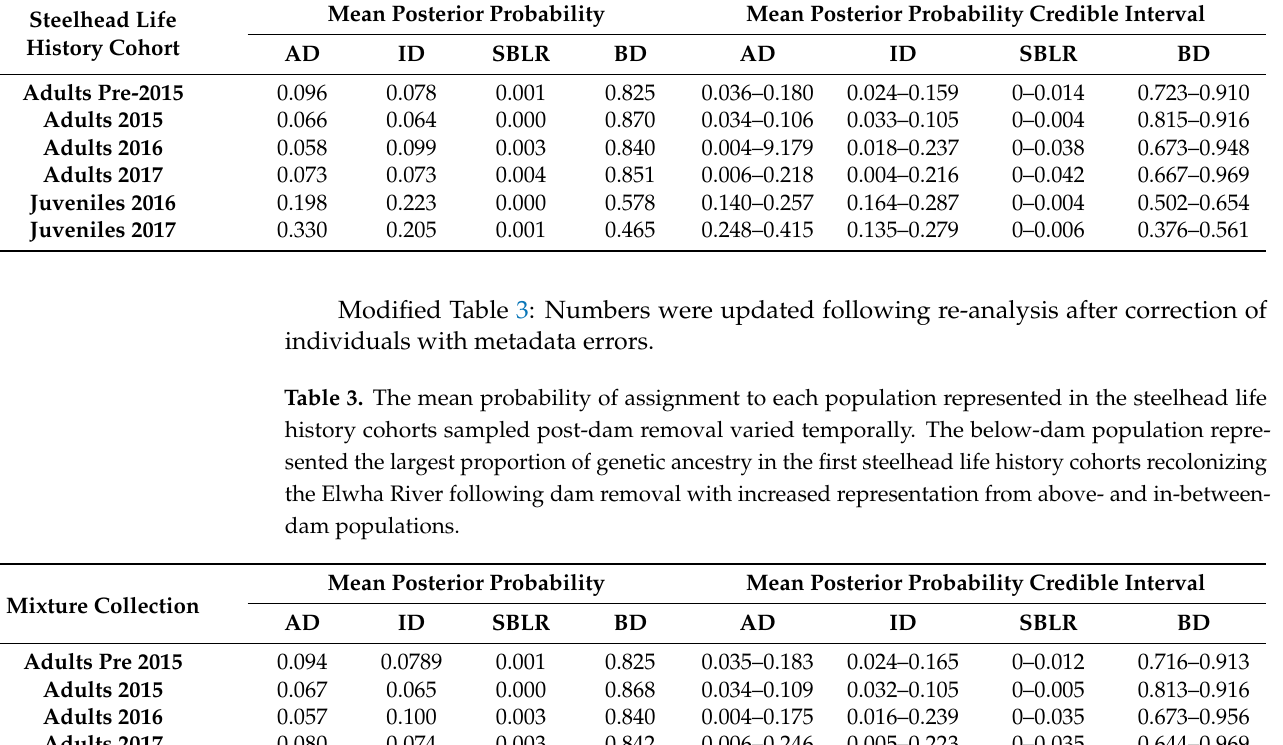
Table 3. The mean probability of assignment to each population represented in the steelhead life